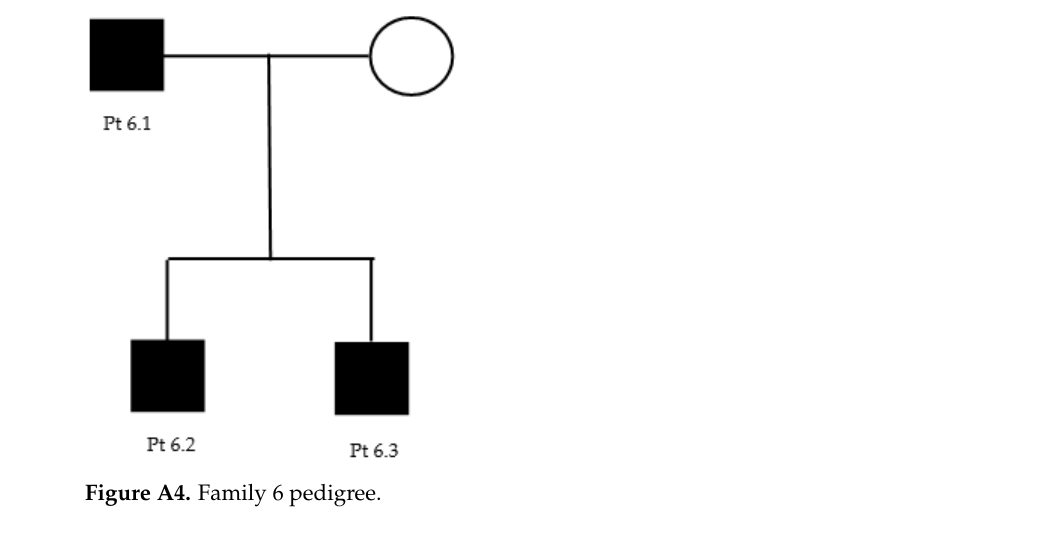
Figure A3. Family 5 pedigree.